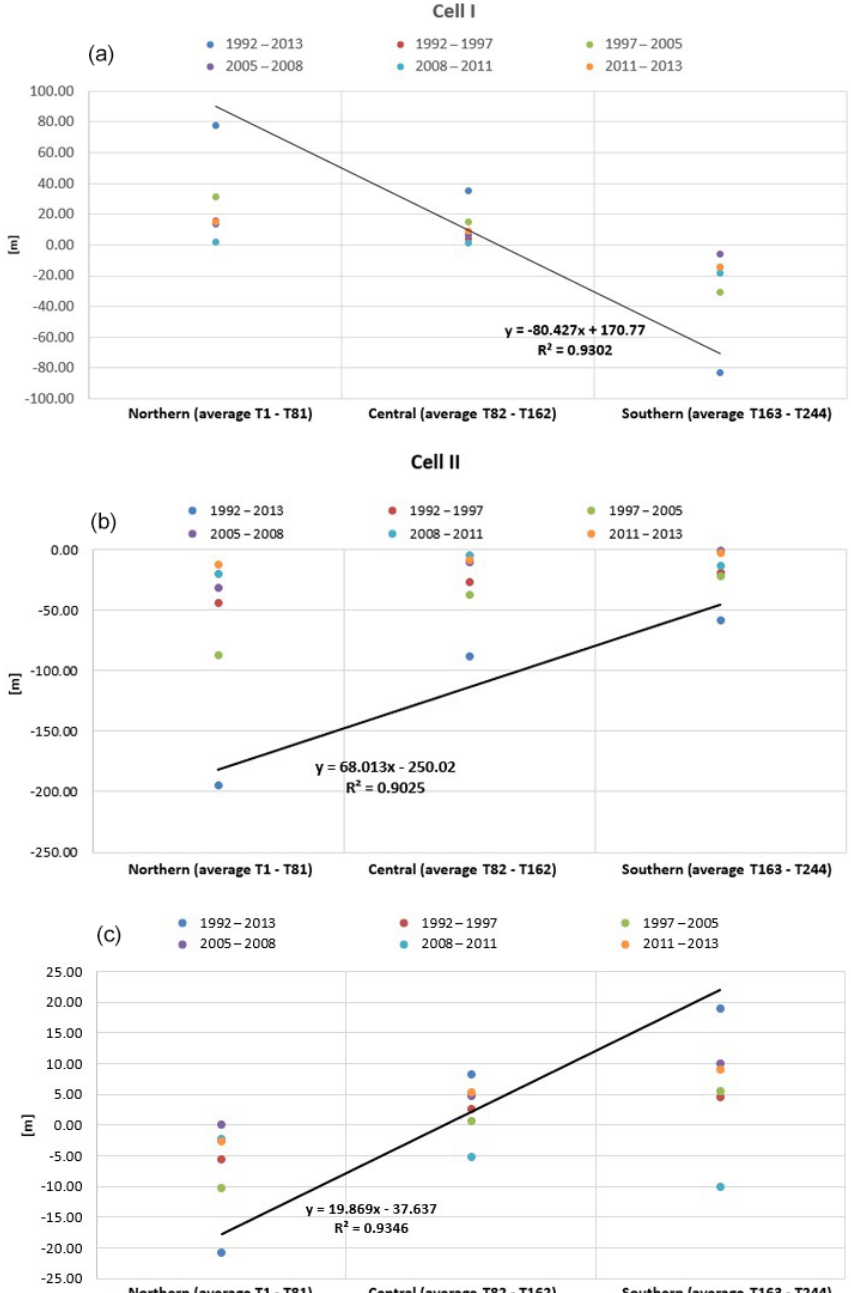
Figure 13. Average variation ( m ) at the northern, central and southern shores in (a) Cell I, (b) Cell II and (c) Cell III for the years